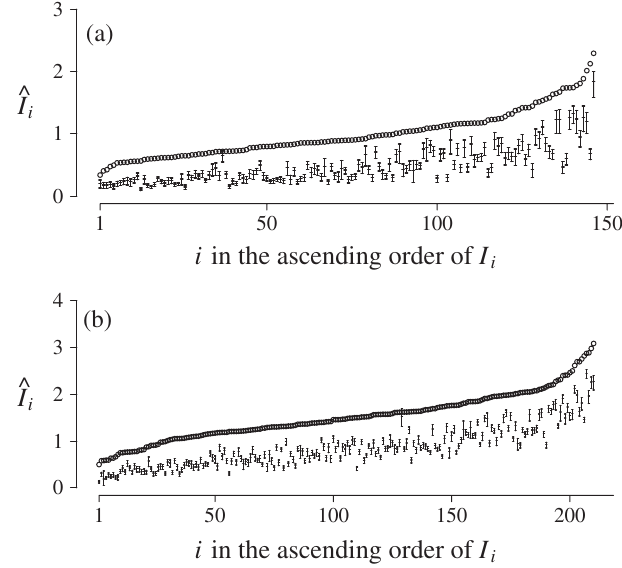
FIG. 12. Results of the bootstrap test of the finite size effect for and (b) D . I i (circles) and the confidential intervals (error (a) D 1 2 bars) of individuals are plotted in the ascending order of I i . The lower and upper ends of the error bars represent 0 and 99 percentile points, respectively. The ticks at the middle of the error bars indicate the